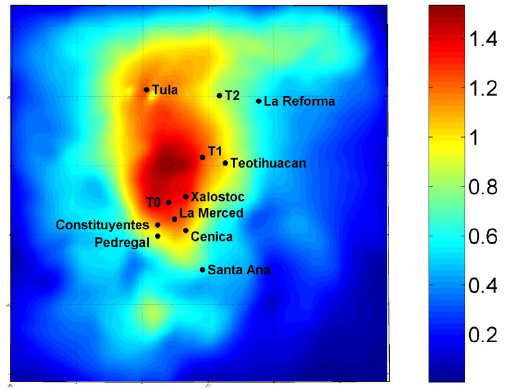
Fig. 11. Predicted increase in ground-level concentrations (µgm − 3 ) of the PM 1 OOA after using a rate constant equal to k (298K)=10 × 10 − 11 cm 3 molec − 1 s − 1 for S-SOA, I-SOA and V- SOA aging reactions.